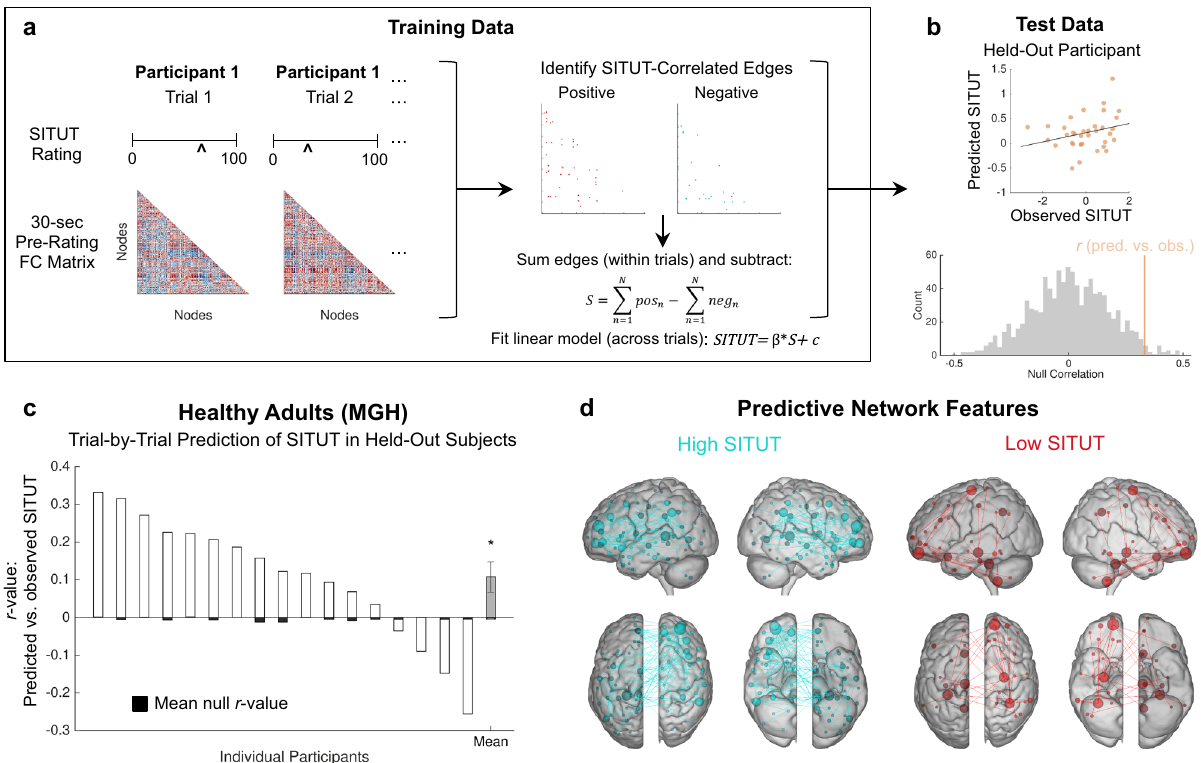
Fig. 1 Functional connectivity-based predictive modeling of trial-wise SITUT fl uctuations within healthy adults. a A schematic of the analysis pipeline. Within training data, SITUT ratings and pre-rating functional connectivity matrices (based on a 268-node whole-brain atlas) were extracted for each trial. Red and blue, respectively, indicate positive and negative functional connectivity. Edges that were correlated with SITUT rating were identi fi ed at a threshold of P < 0.01 (uncorrected), and a summary score was obtained for each trial based on a subtraction of positive and negative edge sums. b A linear model, based on summary scores, was used to correlate 36 predicted versus observed SITUT ratings in a held-out participant (top). Subsequently, that correlation value (indicated with orange line) was compared with a null distribution of r values derived from 1000 permutations of shuf fl ed SITUT ratings (bottom). c Predicted versus observed SITUT correlations, and mean null correlations, within each held-out participant. The gray bar indicates the mean across individuals (i.e., mean across white bars; n = 17). At the group level, predicted versus observed correlations were signi fi cantly greater than mean null correlations ( P = 0.019, two-sided, Wilcoxon signed-rank test). Source data are provided as a Source data fi le. d Edges strongly contributing positively (blue) and negatively (red) to the predictive model. A degree threshold of 6 was applied; i.e., nodes involved in at least 6 contributing edges are displayed. Error bars indicate standard error of the mean. SITUT stimulus-independent, task-unrelated thought. * P <